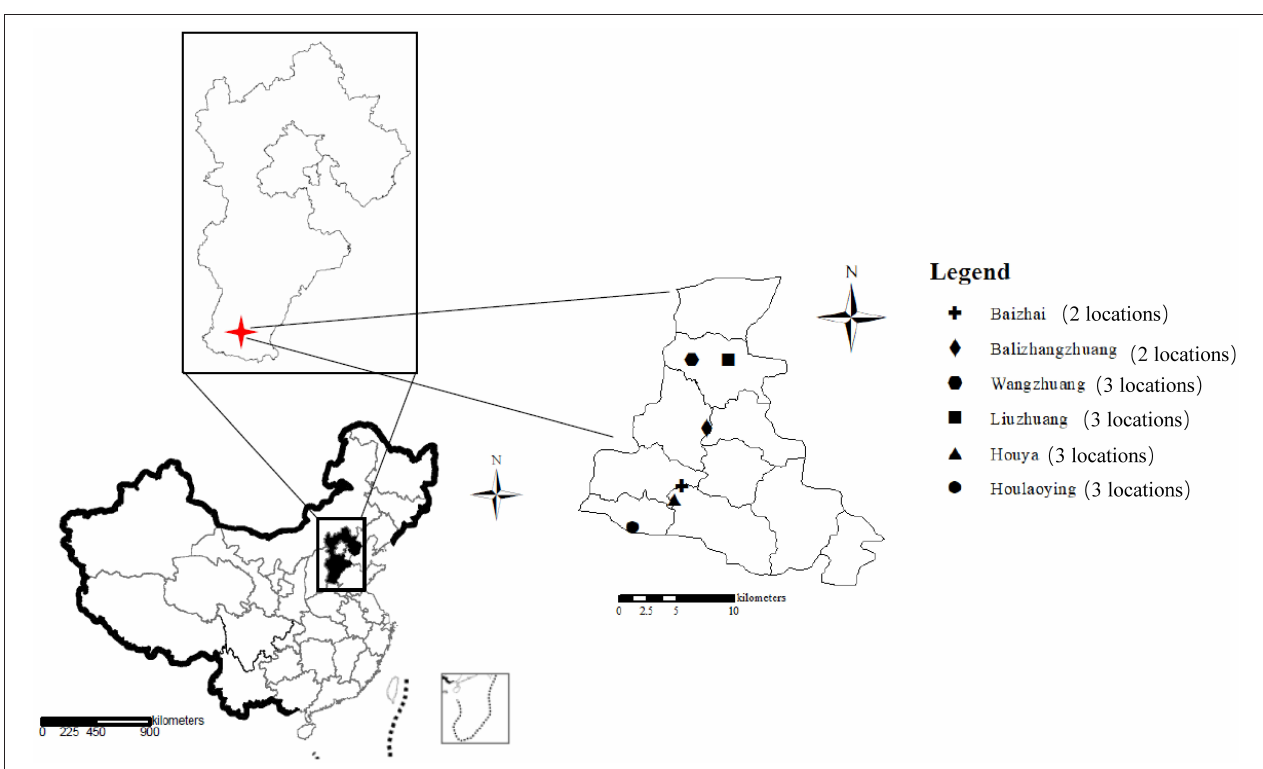
FIGURE 1 | The locations where the field experiments were conducted in Quzhou County, Hebei Province of China. Sixteen experimental locations are located in the 6 villages in Quzhou